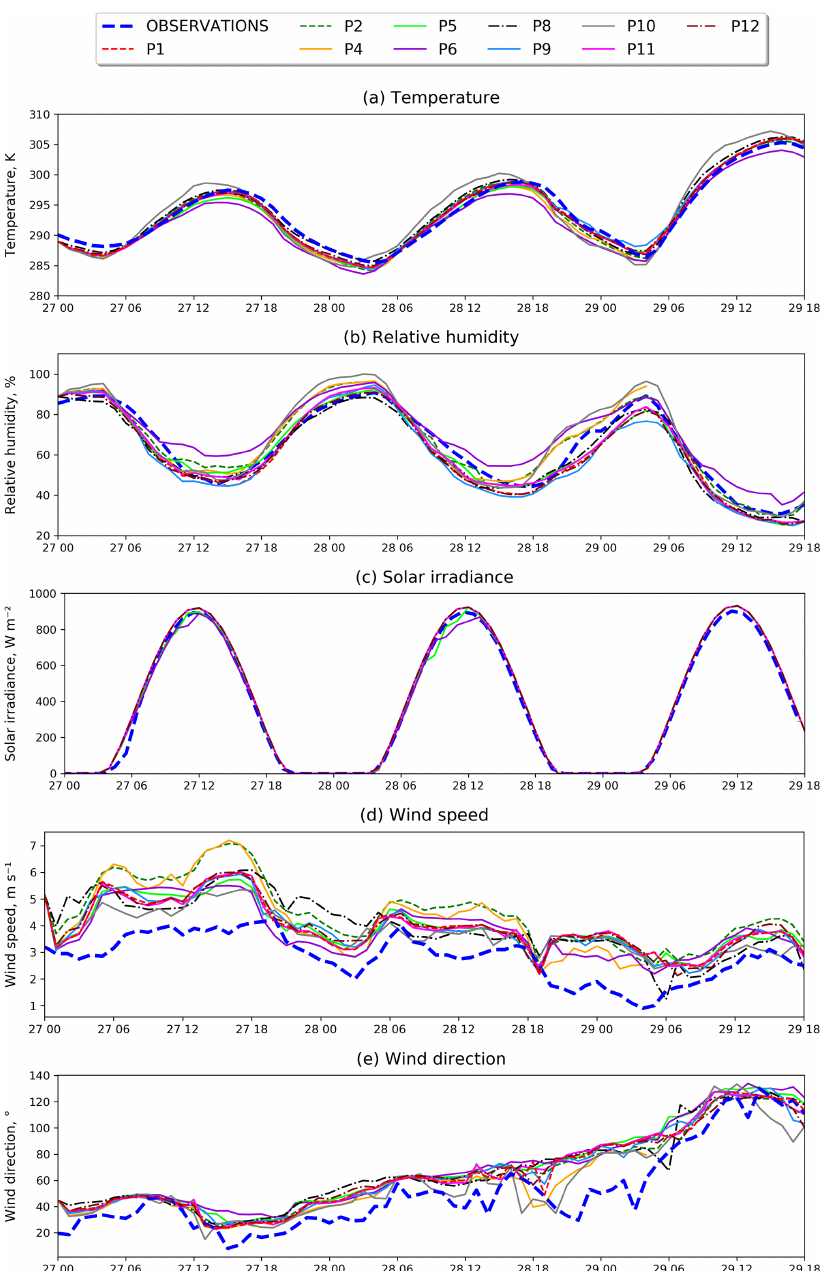
Figure 7. Observed and modeled evolution of surface meteorological parameters on 27–29 June 2019. (a) Temperature, (b) relative humidity, (c) solar irradiance, (d) wind speed, and (e) wind direction. The dark blue dashed line represents the observations, averaged over the two measuring sites, while the other lines represent the output from the model sensitivity runs, labeled in the legend (see Table